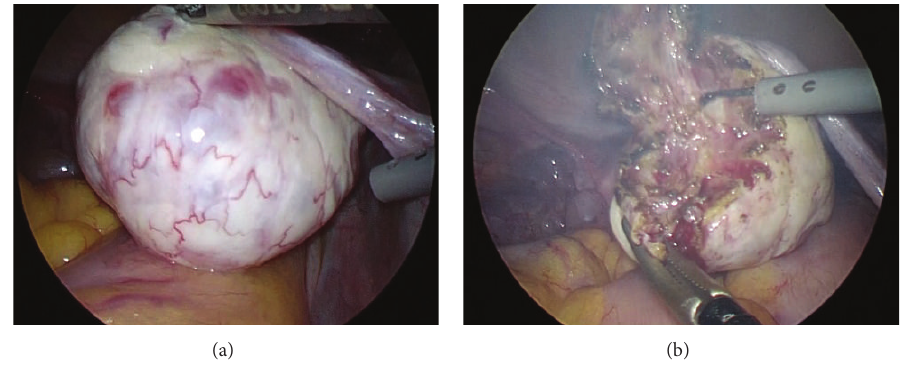
Figure 2: Laparoscopic surgery. (a) The macroscopic appearance of the right ovary did not show any abnormalities. (b) Partial resection of the right ovary was done by removing small pieces at a time starting from the most likely location of the teratoma, with reference to the diagnostic image where the teratoma was identified.